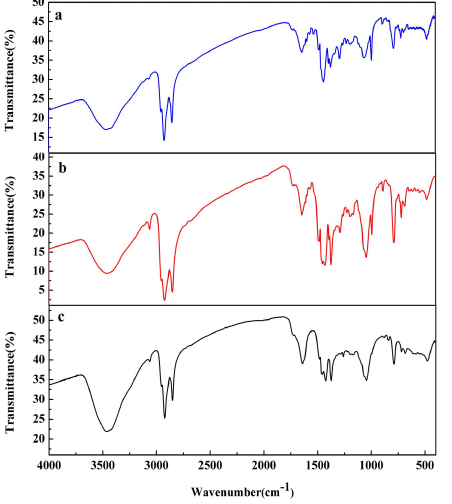
Figure 1. FT-IR spectra of P1 ( a ); P2 ( b ); and P3 ( c